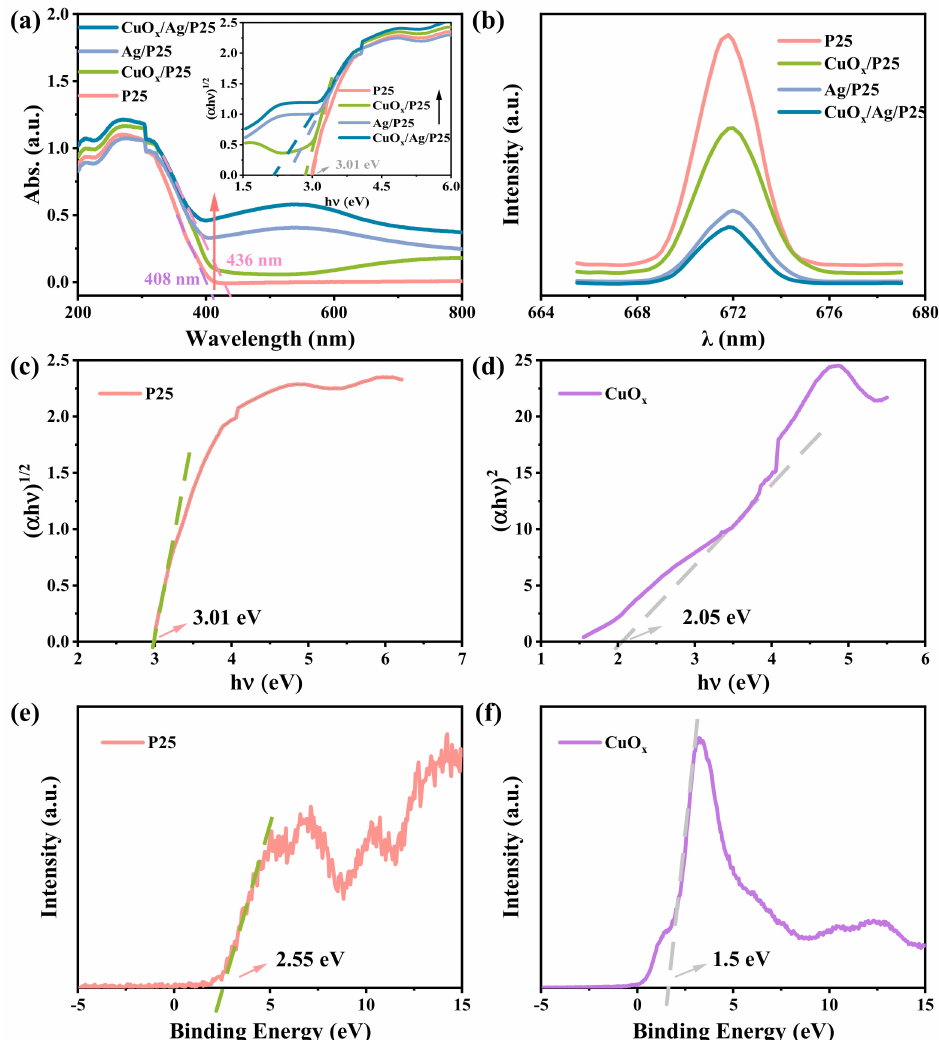
Figure 3. ( a ) UV − vis DRS, dependence of ( α h ν ) 2 on the photon energy (the inserts) and ( b ) pho- toluminescence spectra ( λ ex = 550 nm) of P25, CuO x /P25, Ag/P25, and CuO x /Ag/P25 at room temperature. Dependence of ( α h ν ) 2 on the photon energy for ( c ) P25 and ( d ) CuO x . XPS valence- band spectra of ( e ) P25 and ( f ) CuO x